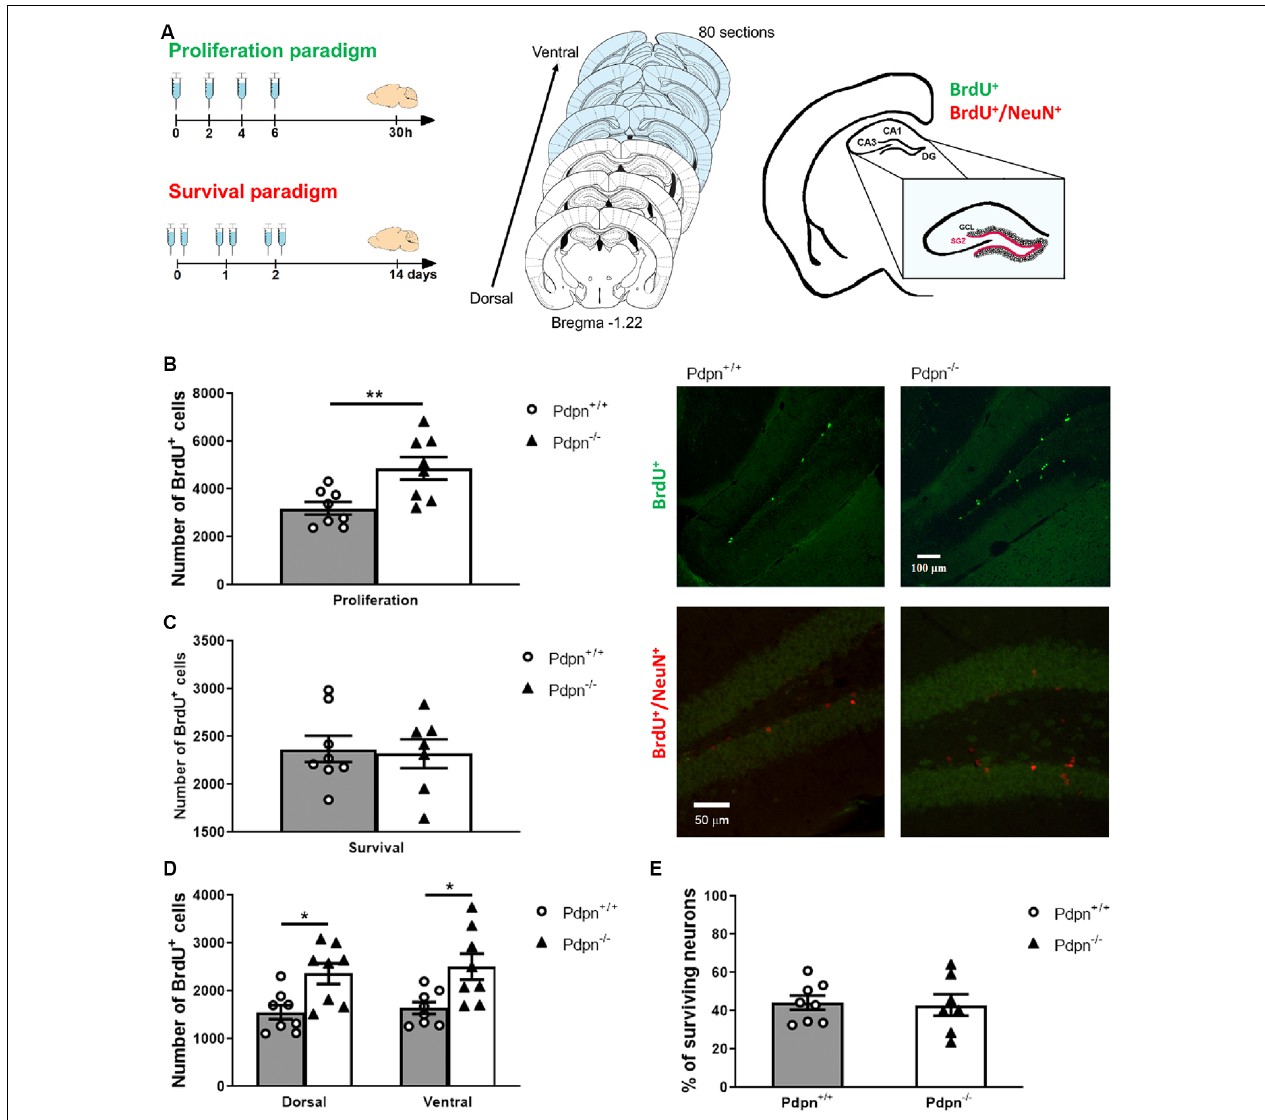
FIGURE 1 | Lack of Podoplanin increases the proliferation of cells in the subgranular zone (SZG) of the dentate gyrus (DG). (A) Schematic representation of 5-bromodeoxyuridine (BrdU) injection protocols for proliferation and survival paradigms (left panel). Schematic representation span of the rostrocaudal axes from which coronal sections were collected (middle). The depicted coronal sections have been modified from Franklin and Paxinos (2013). The SGZ spans at the border of the granule cell layer (GCL) and hilus of the hippocampal DG (right panel). (B) Analysis of the approximated number of BrdU + cells per hippocampus in “proliferation” paradigm showed a significant difference between two genotypes ( ∗∗ P = 0.008, t ( 14 ) = 3.122, n = 8 per group). Representative photomicrographs of Pdpn + / + and Pdpn − / − coronal sections immunostained against BrdU in the “proliferation” paradigm (right panel 10 × magnification). (C) In the “survival” paradigm quantification of BrdU + cells showed no differences between hippocampi of Pdpn + / + and Pdpn − / − mice ( P = 0.819, t ( 13 ) = 0.233, n = 7–8 per group). Representative photomicrographs of Pdpn + / + and Pdpn − / − coronal sections immunostained against BrdU in red and against NeuN in green in the “survival” paradigm (right panel 20 × magnification). (D) Two-way ANOVA of the number of BrdU + cells in “proliferation” paradigm between dorsal and ventral hippocampus showed a main significant effect of genotype ( ∗∗∗ P < 0.0002, F ( 1,28 ) = 17.61, n = 8 per group), no significant effect of the area ( P = 0.5601, F ( 1,28 ) = 0.3477, n = 8 per group) and no significant interaction between paradigm and genotype ( P = 0.8912, F ( 1,28 ) = 0.0190, n = 8 per group). Post hoc analysis showed significant difference between Dorsal:Pdpn + / + and Dorsal:Pdpn − / − ( ∗ P = 0.0366), Dorsal:Pdpn + / + and Ventral:Pdpn − / − ( ∗ P = 0.0108), as well as Ventral:Pdpn + / + and Ventral:Pdpn − / − ( ∗ P = 0.0233), as represented with asterisks on the graph. (E) Quantification of surviving cells double-labeled with BrdU + and NeuN + showed no significant difference in a number of surviving neurons in Pdpn − / − mice compared to their Pdpn + / + littermates ( t ( 13 ) = 0.1857, P = 0.9, n = 7–8). Data are displayed as mean ± SEM.